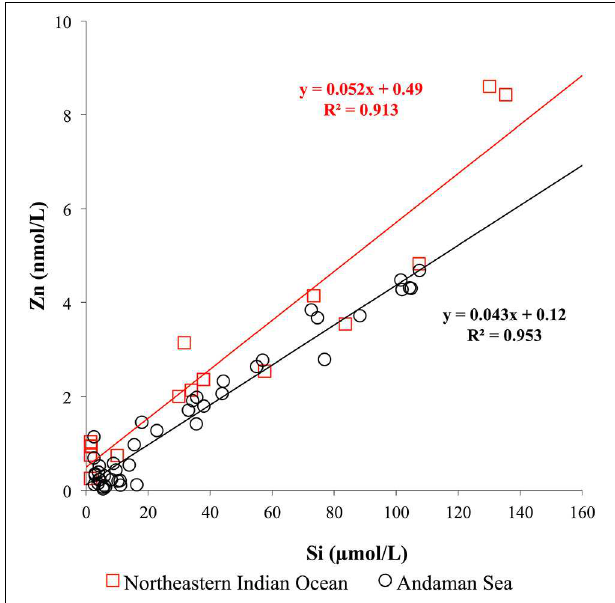
FIGURE 6 | Relationship between C Zn and Si in seawater obtained in the northeastern Indian Ocean and the Andaman Sea.